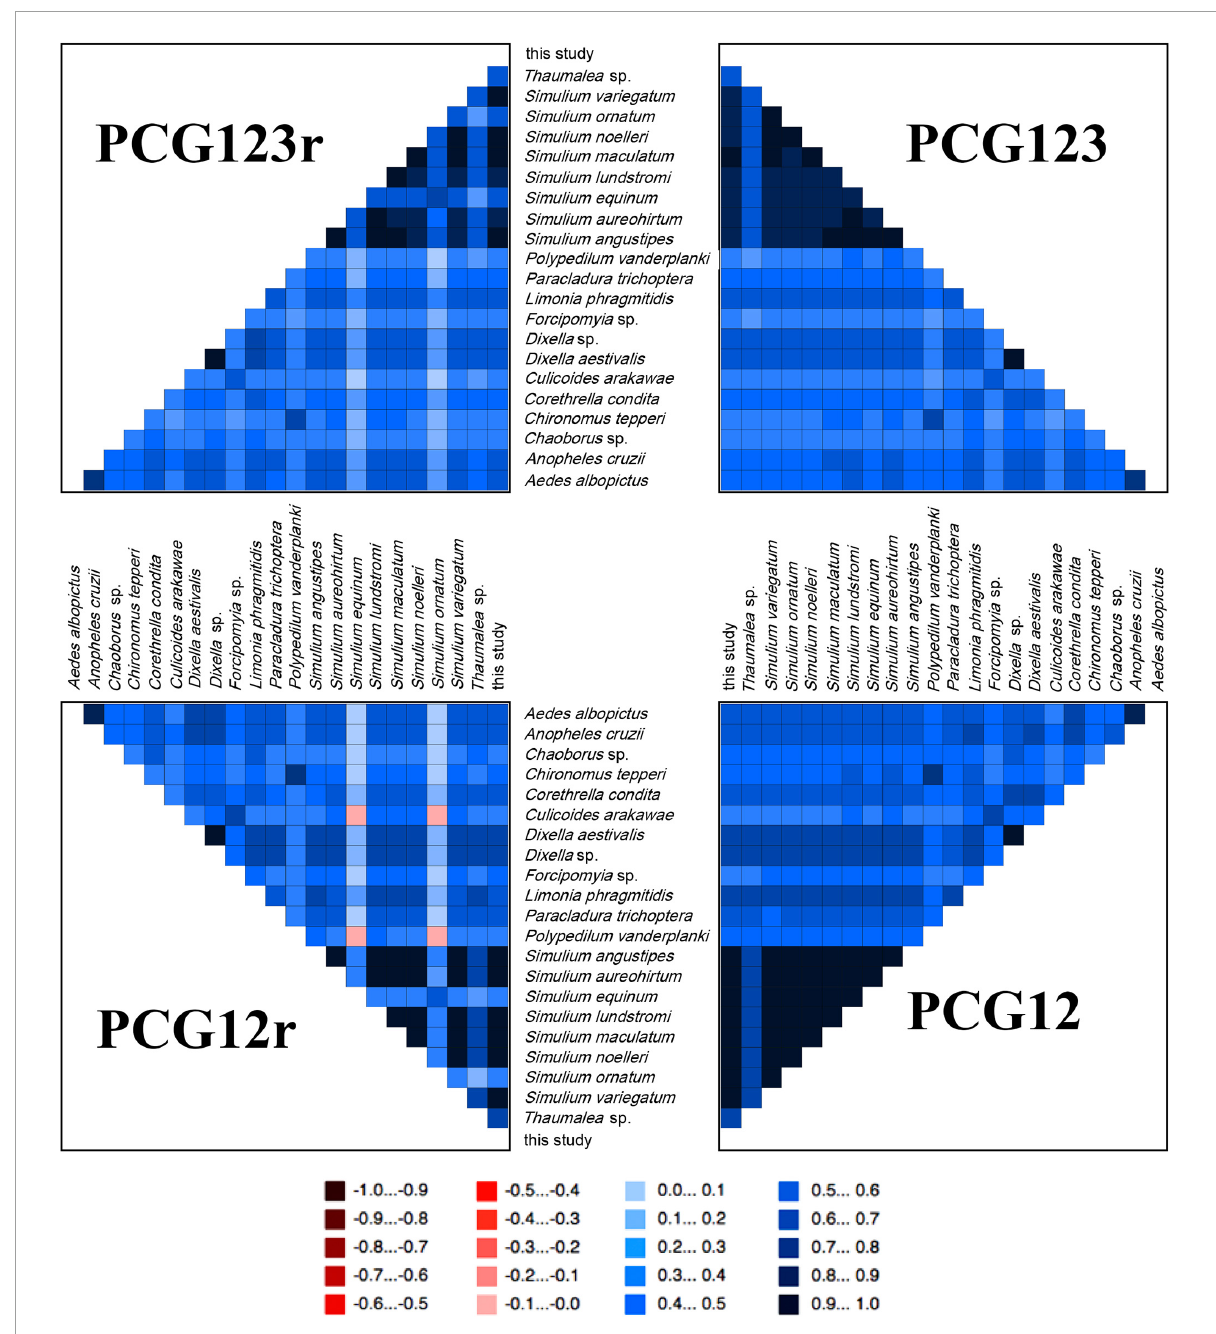
FIGURE6 AliGROOVE analysis for four datasets. The mean similarity score between sequences is represented by a colored square, based on the AliGROOVE scores from –1, indicating great differences in rates from the remainder of the datasets, i.e., heterogeneity (red), to +1, indicating rates match all other comparisons